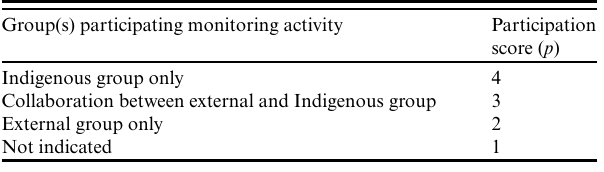
Table 3 . Groups participating in monitoring activities